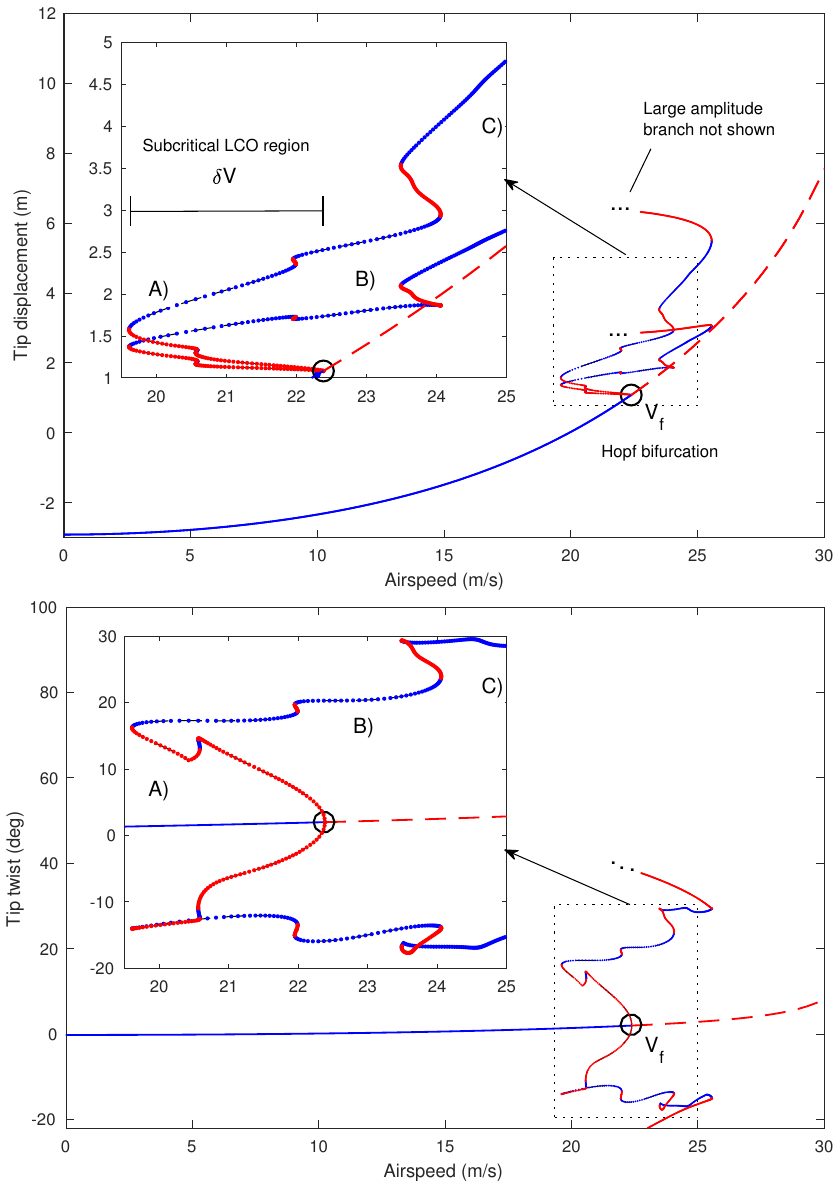
Figure 6. One-parameter continuation of equilibria and LCOs for varying airspeed, showing solutions near flutter boundary; blue = stable, red =